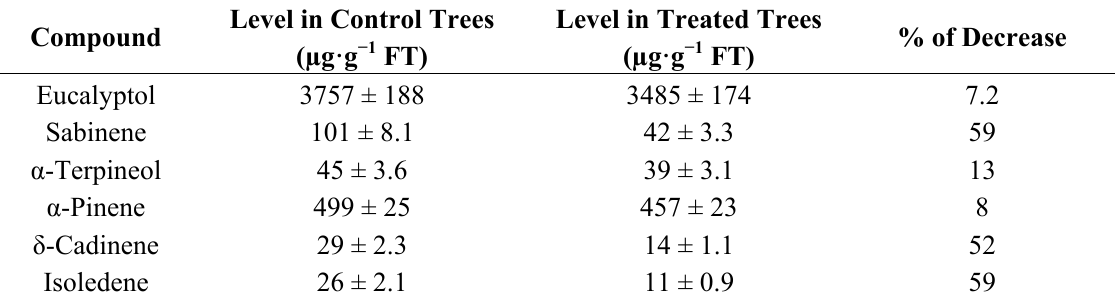
Table 1. Levels of the main terpenoids in leaves of control Eucalyptus and in trees treated with OC